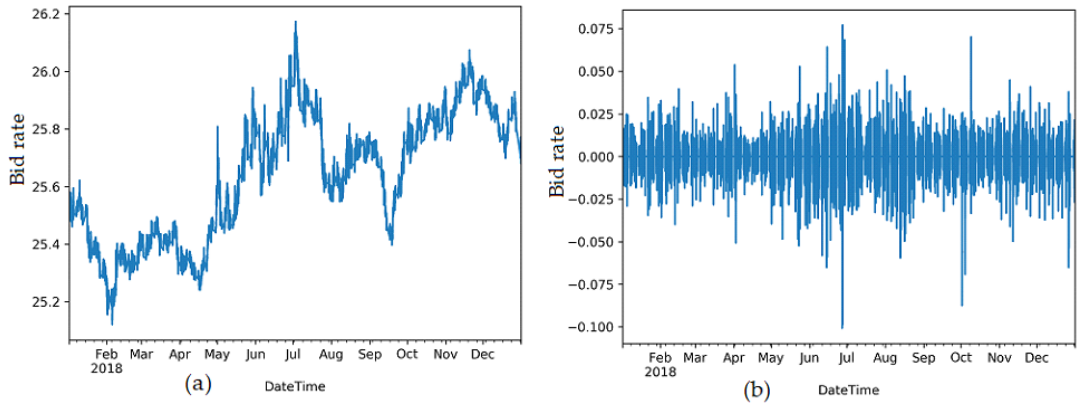
Figure 1. The time plot of exchange rate price between EUR/CZK from January 2018 17:01:00 to 31 December 2018 16:58:00 without duplicates ( a ), and after first differencing ( b ). Processed in Python 3.4 (Appendix